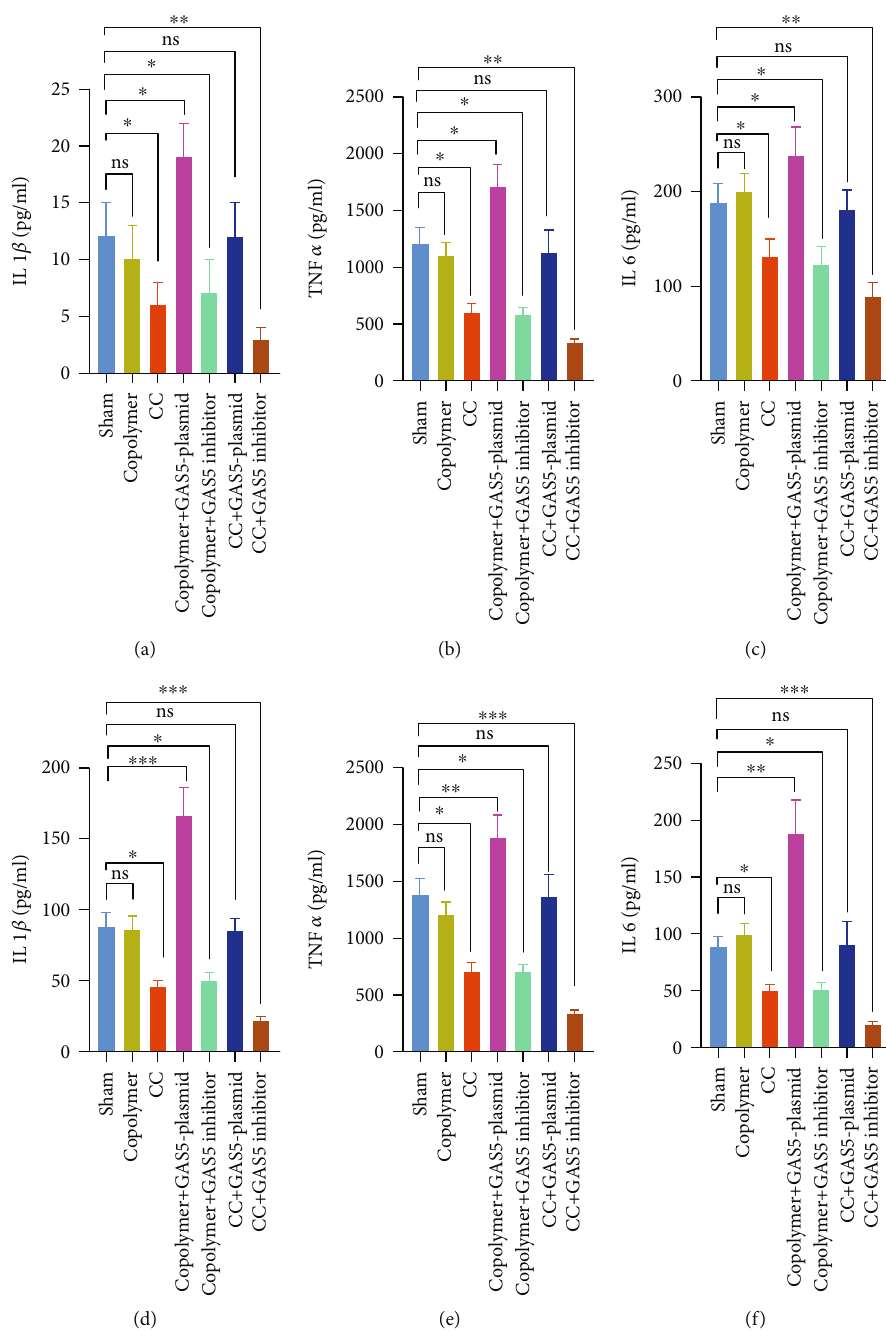
Figure 5: Triblock copolymer-encapsulated curcumin nanomicelles regulate the expression of GAS5-induced cytokines. (a – c) The expression of cytokines IL-1 β (a), TNF- α (b), and IL-6 (c) in plasma. (d – f) The expression of cytokines IL-1 β (d), TNF- α (e), and IL-6 (f) in brain tissue ( ∗ P < 0 : 05 , ∗∗ P < 0 : 01 , and ∗∗∗ P < 0 : 001 ; ns: not signi fi